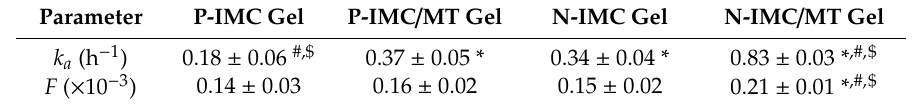
Table 2. Pharmacokinetic analysis of percutaneous absorption of the IMC transdermal formulations.